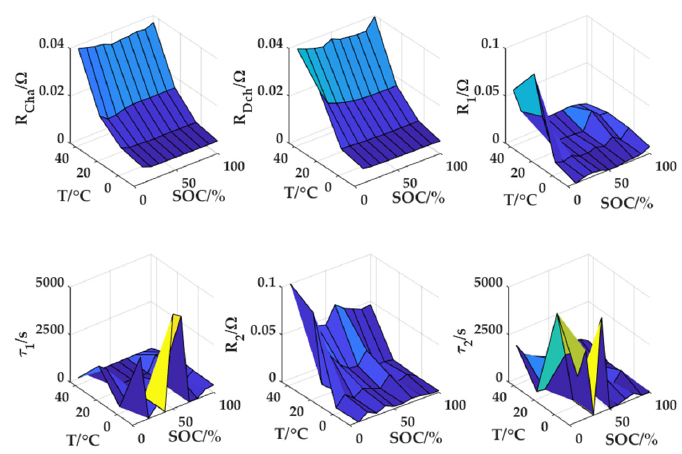
Figure 8. Identification results of each temperature parameter.